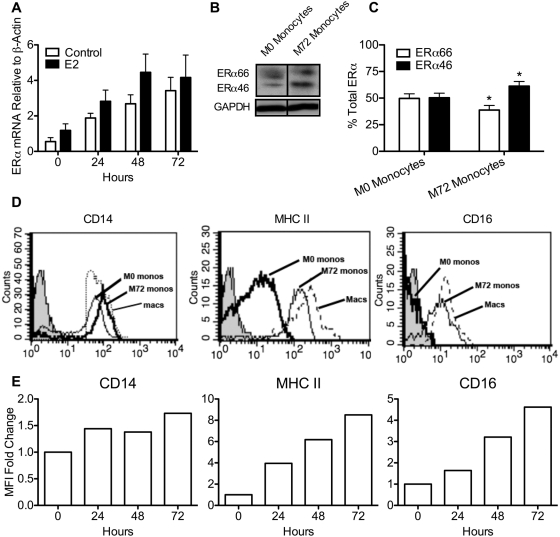
ERα expression increases during monocyte-to-macrophage differentiation.
A, monocytes were cultured for 0, 24, 48 or 72 hrs with 10−7 M E2 or ethanol control and ERα mRNA expression was measured and normalized to β-actin expression. B, ERα protein expression of monocytes (M72) cultured for 0 hrs and 72 hrs. C, comparison of ERα66 and ERα46 expression at 0 and 72 hrs expressed as percent total ERα. *, p<0.05 compared to monocytes. D, flow cytometric analysis of freshly isolated monocytes (M0), monocytes cultured for 72 hours (M72), and monocytes differentiated with GM-CSF for 7 days (macs). Cells were stained for surface expression of CD14, MHC II and CD16. E, change in mean fluorescence intensity in monocyte expression of CD14, MHC II and CD16 following 0, 24 hrs, 48 hrs and 72 hrs of culture.